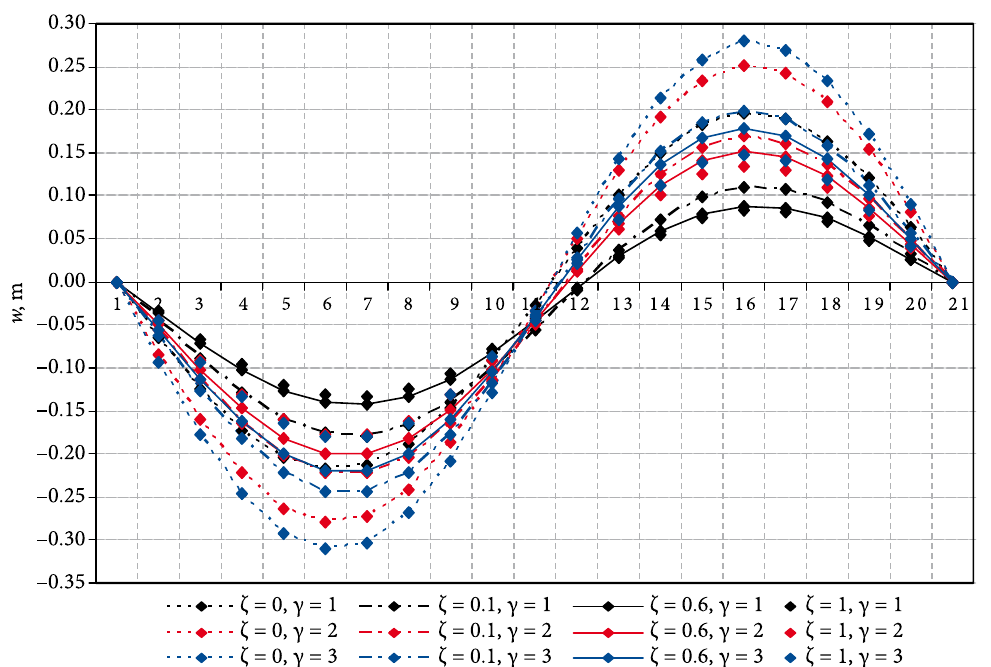
Fig. 6 . Vertical displacement curves under unsymmetrical loading of two-hinged